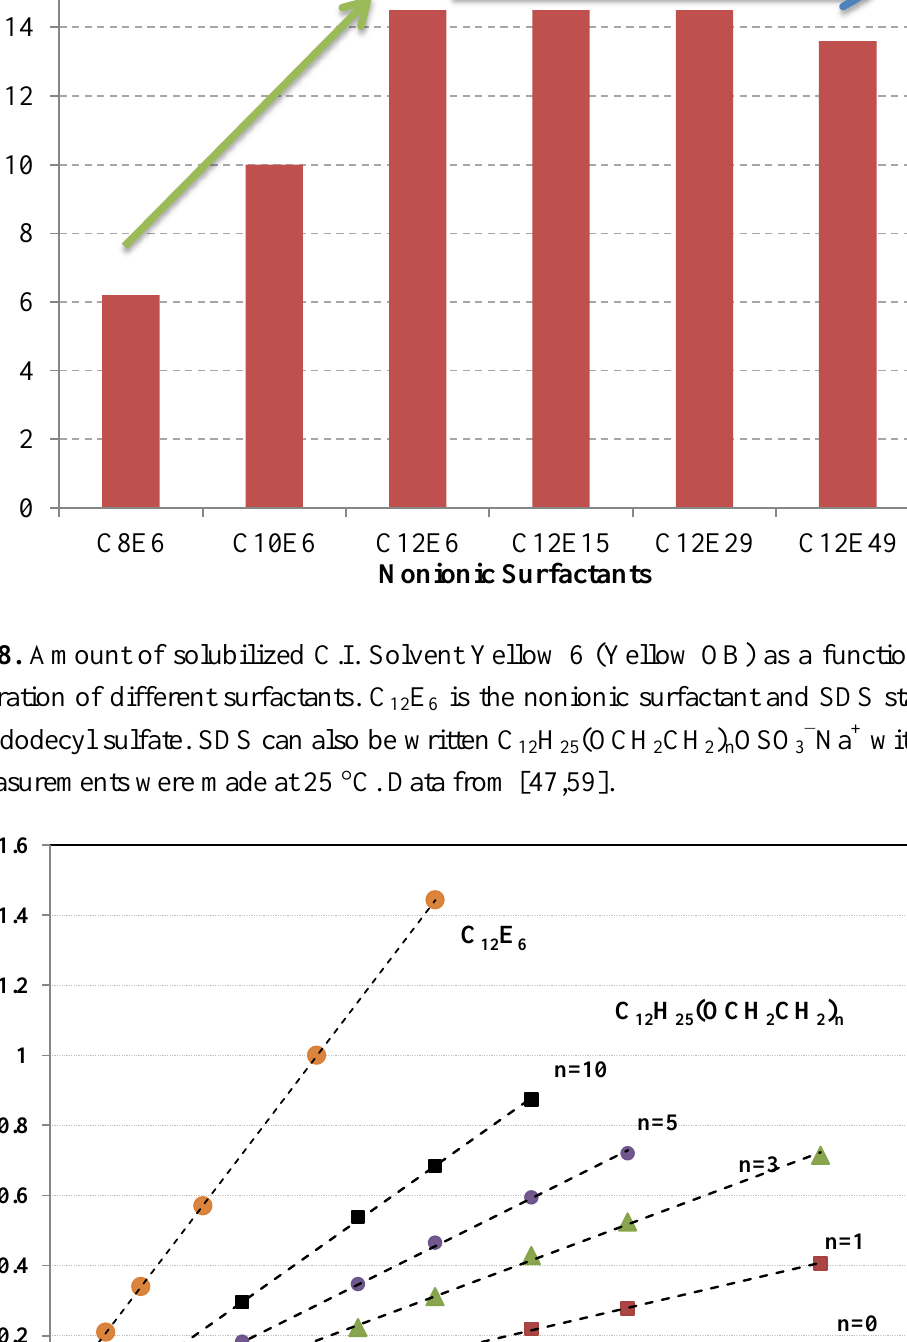
Figure 7. Solubilization of C.I. Solvent Yellow 6 (Yellow OB ) in aqueous solutions of a series of nonionic surfactants (C